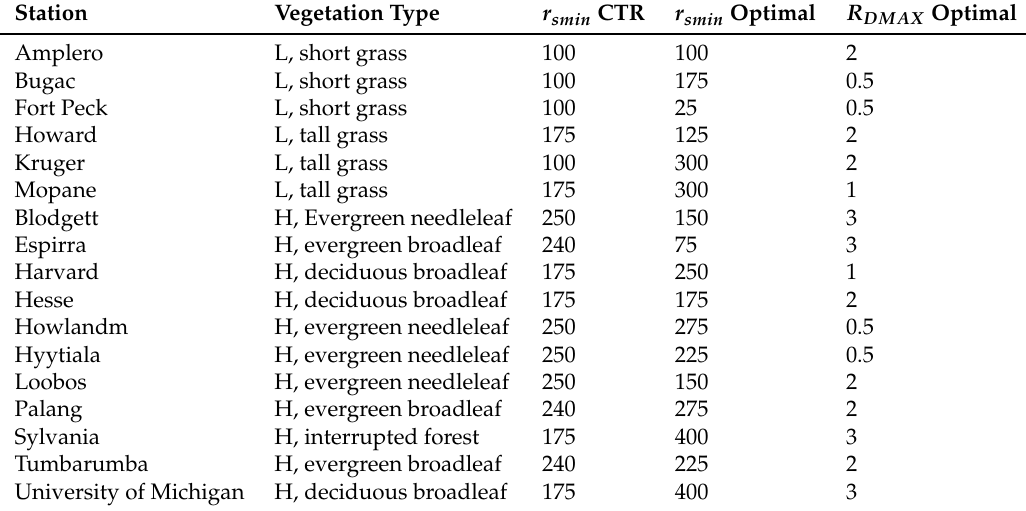
Table 2. Control (CTR) r smin and optimal r smin and R DMAX used in MLAI_RSMINand MLAI_ROOT, respectively (L defines low and H high vegetation types).